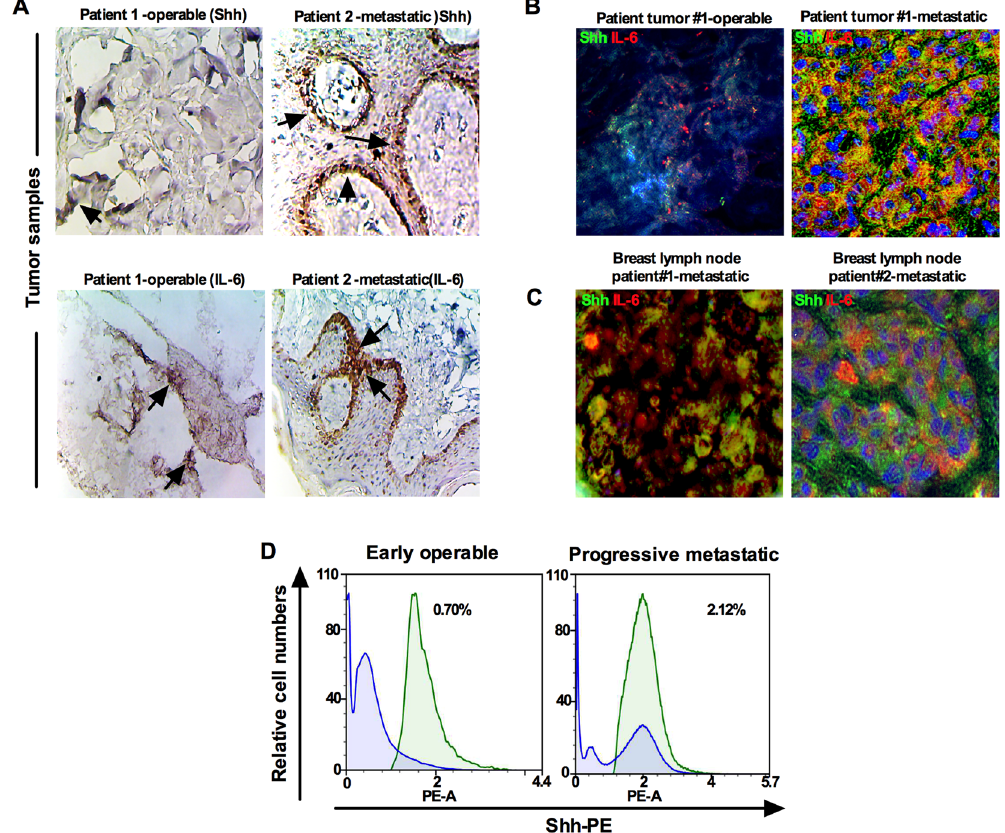
samples, and ( C ) Dual immunofluorescence staining of Shh (green) and IL-6 (red) in diagnostic lymph nodes samples. ( D ) Blood cells isolated from early operable and progressive metastatic breast cancer patients were immunostained with Shh-PE-conjugated antibody and analyzed by NovoCyte Flow cytometry. Staining is relative to isotype-matched control. Figure shows that Shh is differentially expressed in patient’s blood